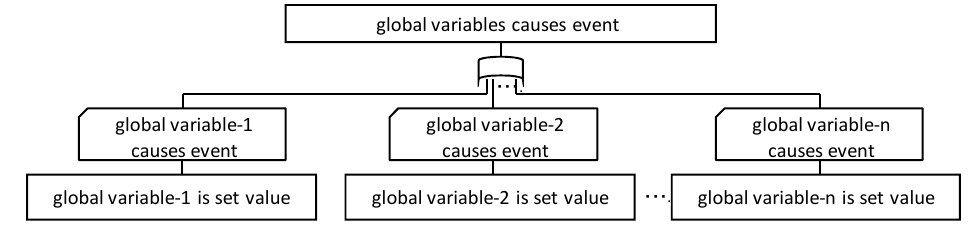
Figure 9. FTT for global variables.